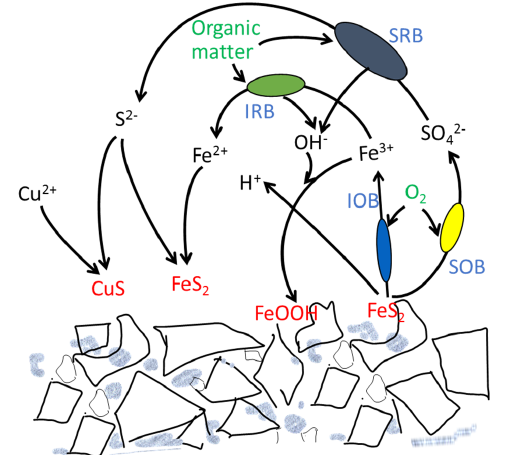
Figure 8. Scheme of the microbial-induced transformation of the minerals for bioremediation of pyritic waste rocks. Sulfide minerals, such as pyrite, are oxidized by IOB and SOB to Fe 3+ and SO 42 − under aerobic conditions and form the acid mine drainage. After the creation of the anaerobic condition, and input of organic matter, the acidic IRB reduce Fe 3+ to Fe 2+ and elevate the pH, and then the less acid-tolerant SRB and IRB grow, thus the pH increases gradually, and, finally, the metal ions precipitate together with the microbial generated sulfide and with the elevated pH. SOB: sulfur oxidizing microbes, IOB: iron oxidizing microbes; IRB: iron reducing microbes; SRB: sulfur reducing microbes.